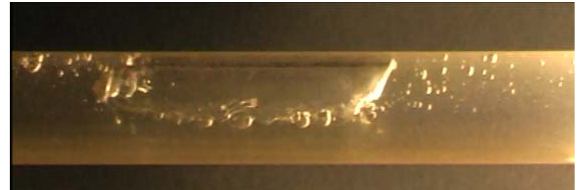
Fig. 2. Fragment of a large bubble entrusts resulting from the slug flow.